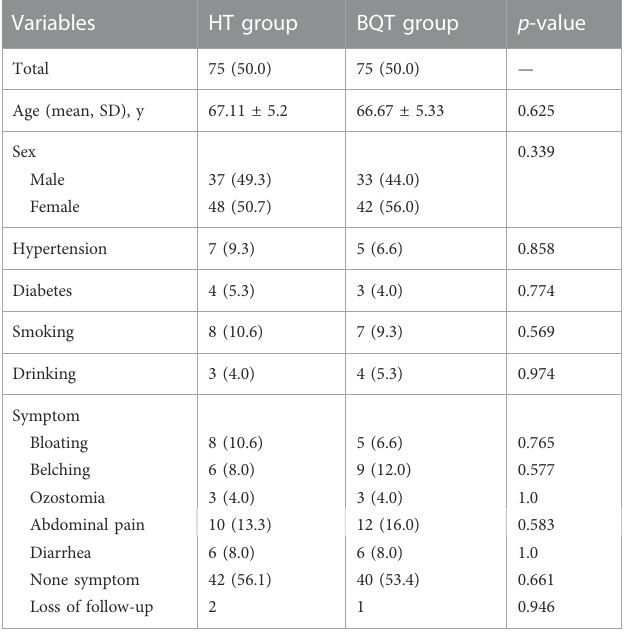
TABLE 1 Demographic and clinical data of